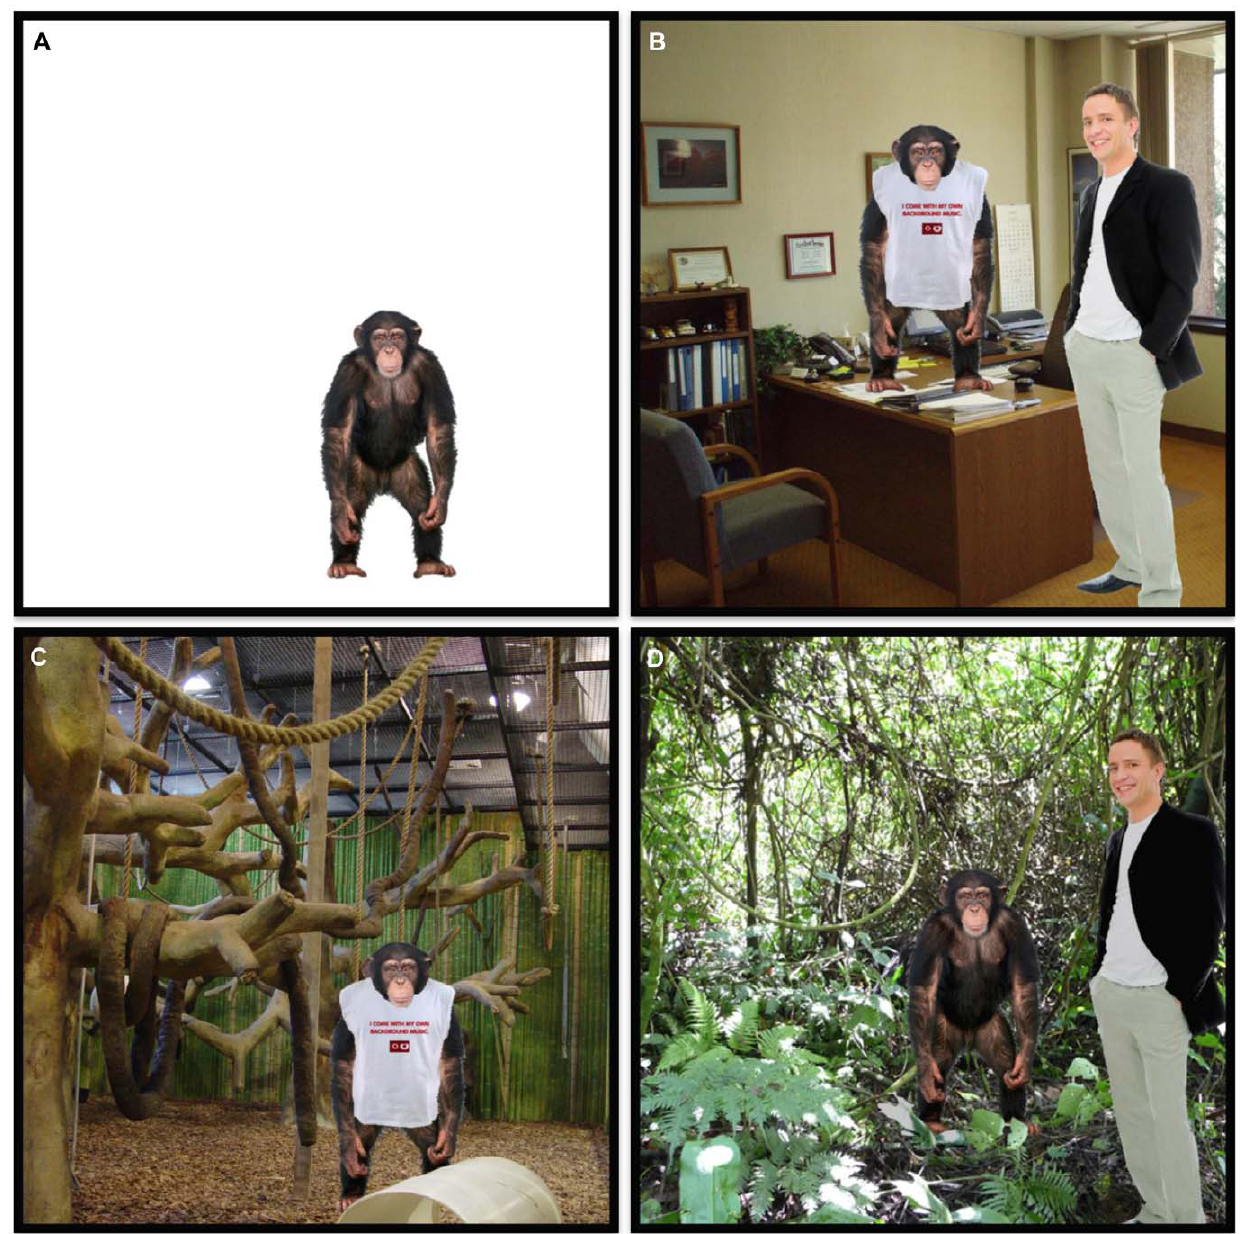
Figure 1. Sample images provided to survey respondents. Detailed legend: Each image was characterized by four variables: clothing (two levels: clothed and unclothed), human presence (two levels: human present, no human present), setting (four levels: a blank, neutral background, an anthropomorphic setting which depicted a typical office setting, a modern zoo setting in which artificial exhibit elements and wire mesh caging were visible, and a naturalistic, jungle bgackground), and media (three levels: photograph, cartoon, pencil line drawing). The images above are a sample of the 48 unique images used. (A) chimpanzee unclothed with no human with a neutral background. (B) chimpanzee clothed with a human in an anthropomorphic setting (typical office space). (C) chimpanzee clothed without a human present in a captive setting. (D) chimpanzee unclothed with a human present in a species-typical (jungle) setting.